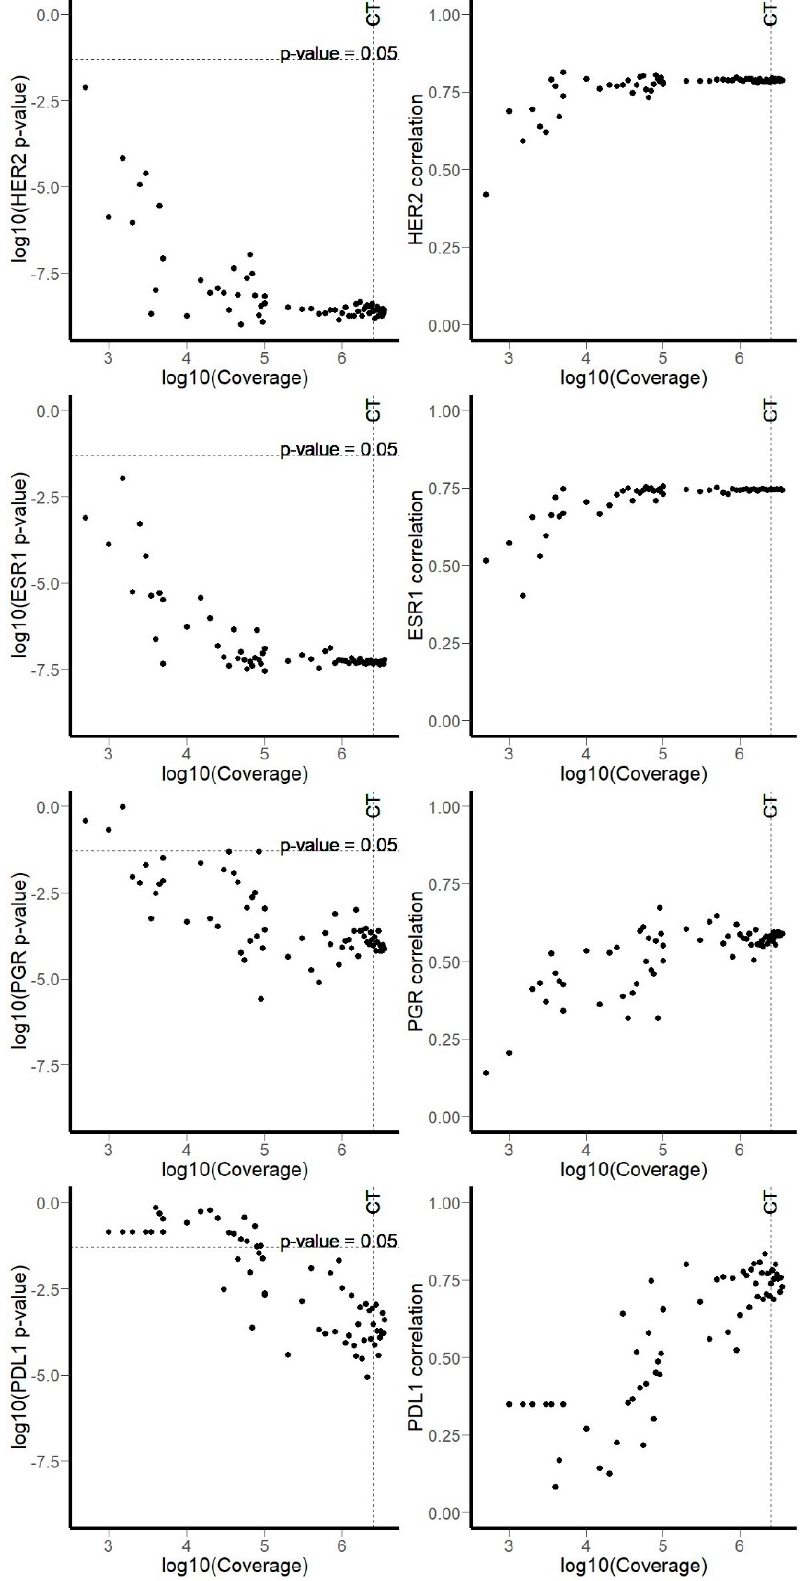
Figure 5. Computational simulation of gene-mapped reads coverage using random reads permutations. Left panels: p -value for Spearman’s rho vs. coverage. Right panels: Spearman’s rho vs. coverage. “CT” indicates coverage threshold of 2,500,000 reads.